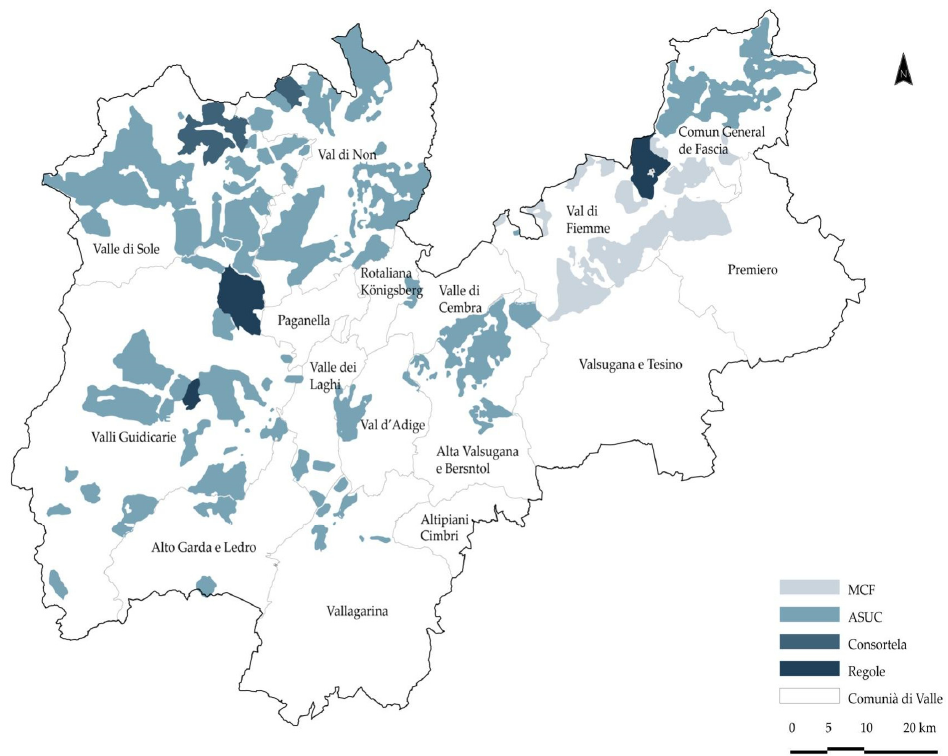
Figure 2. The map shows the partition of the Autonomous Province of Trento into the 15 Valley Communities, local territorial bodies that constitute the intermediate institutional level between the municipalities and the Autonomous Province. Established by Provincial Law no. 3 of 16 June 2006, the role of the Communities, as the associative bodies of the municipalities, is to represent the coordinating authority in making strategic decisions at the provincial level that reflect their impact on local realities. In addition, there are four types of Commons: the ‘MCF’ ( Magnifica Comunità della Val di Fiemme ); the ‘ASUC’ ( Amministrazioni Separate di Uso Civico Trentine), born on 13 April 1987, amounting to approximately 102; the ‘Consortele’ in Val di Rabbi (today comprising 23 associations owning 5. 320 hectares of land and ‘malghe’); the ‘Regole’ of Spinale and Mánez (in the municipalities of Ragoli, Montagne and Preore, an agrarian community existing ab immemorial ), and the Regola Feudale of Predazzo.